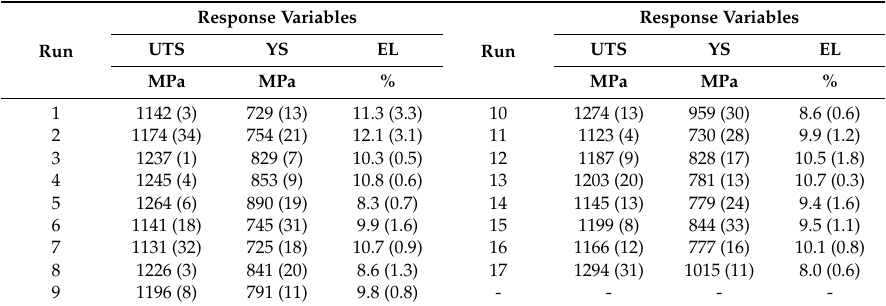
Table 4. Mechanical properties for each of the experimental combination (standard deviation in brackets).